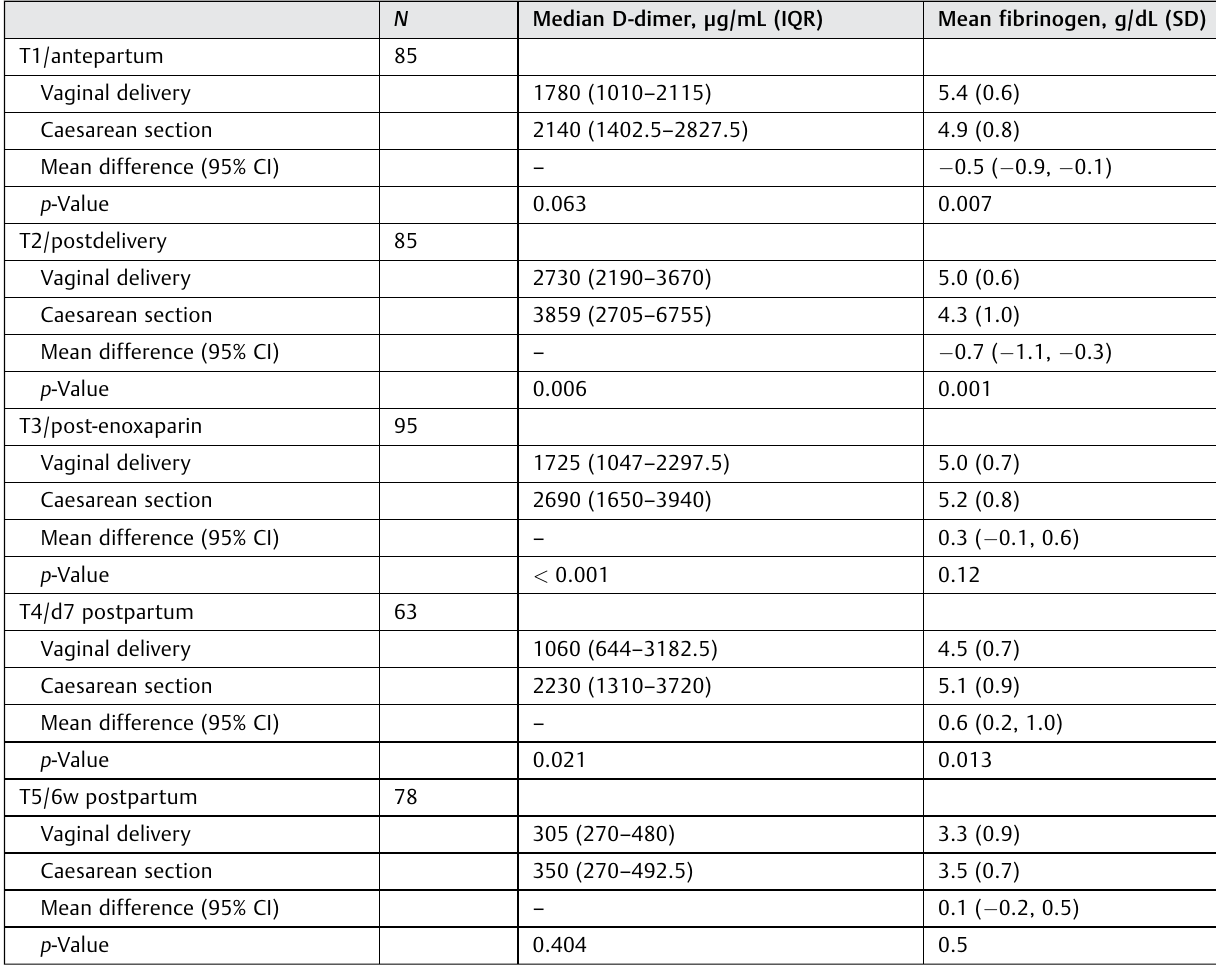
Table 2 Comparison of median D-dimer and mean Clauss fi brinogen between women with vaginal delivery compared with caesarean